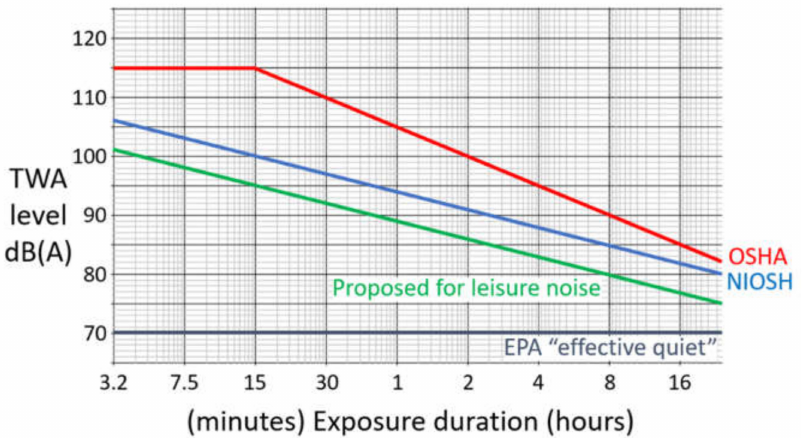
Figure 1. The U.S. National Institute for Occupational Safety and Health maximum time-weighted average (TWA) recommended exposure level (i.e., the NIOSH REL [14] in blue), and the U.S. Occupa- tional Safety and Health Administration maximum TWA permitted exposure level (i.e., the OSHA PEL [16] in red), is plotted as a function of exposure duration. In addition, a recent recommendation for maximum TWA exposure levels for leisure noise [68,69] is plotted (in green), along with the U.S. Environmental Protection Agency (EPA) “effective quiet” level of ≤ 70 dB(A)